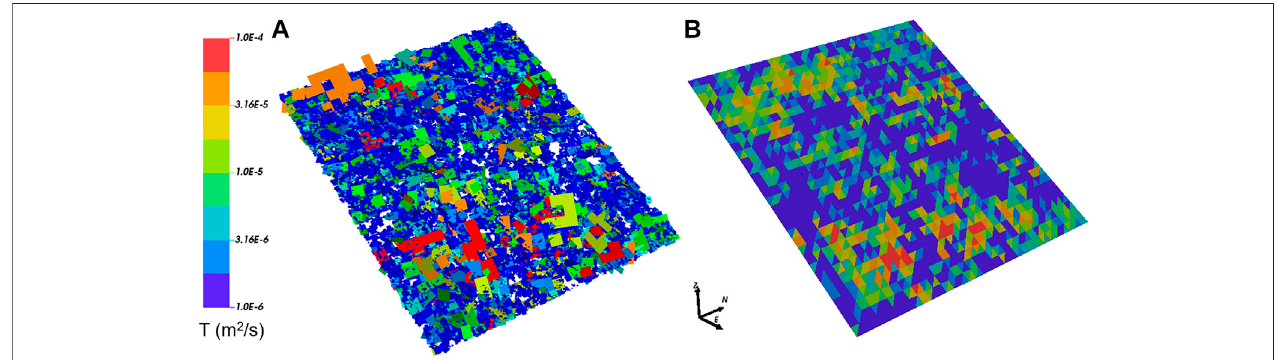
FIGURE 1 | Comparison of BFZ representations; (A) is a single realization of the underlying DFN model; (B) is the plane-projected representation of the same realization. Fractures colored by transmissivity.